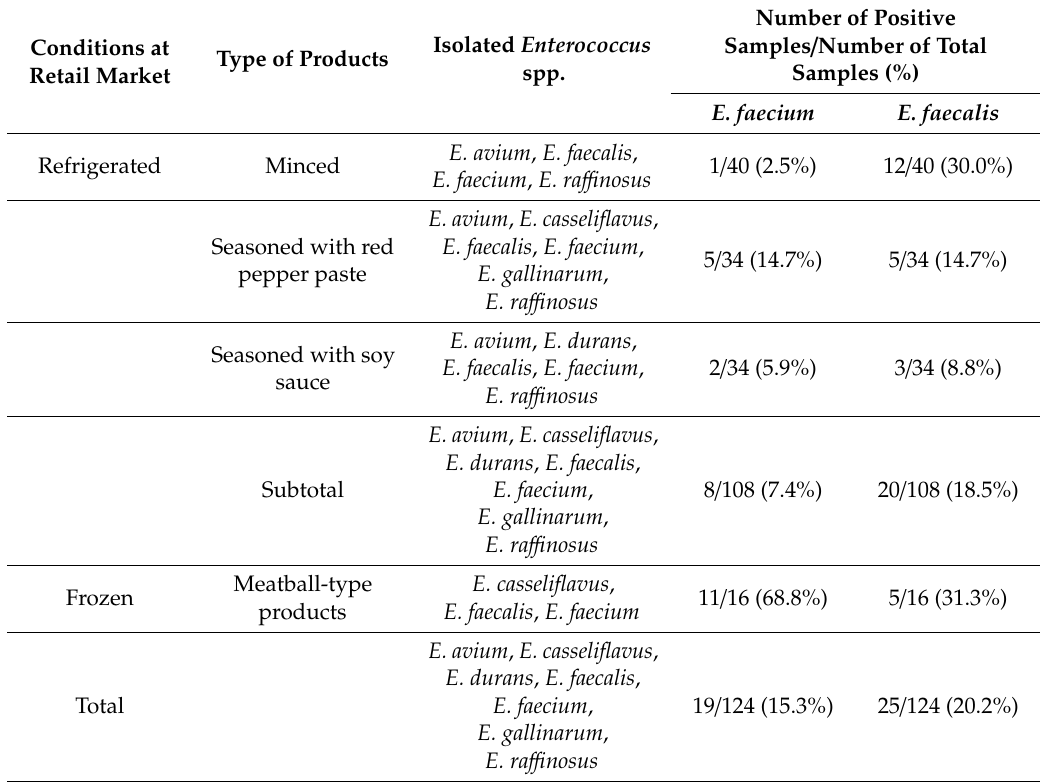
Table 1. Prevalence of Enterococcus faecium and Enterococcus faecalis in commercially available processed pork meat